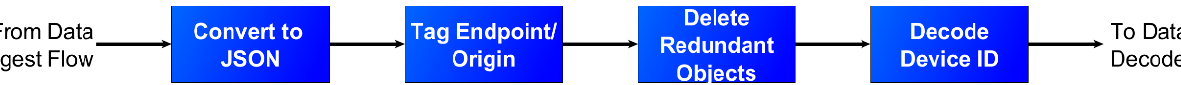
Figure A3. MQTT topic subscriber-based data ingest step for device data integration.